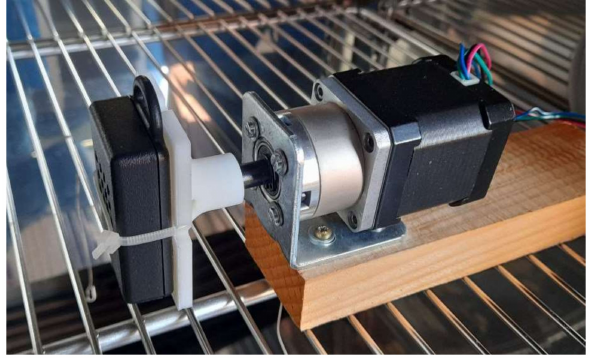
Figure 17. Sensor node mounted on the stepper motor in the climatic